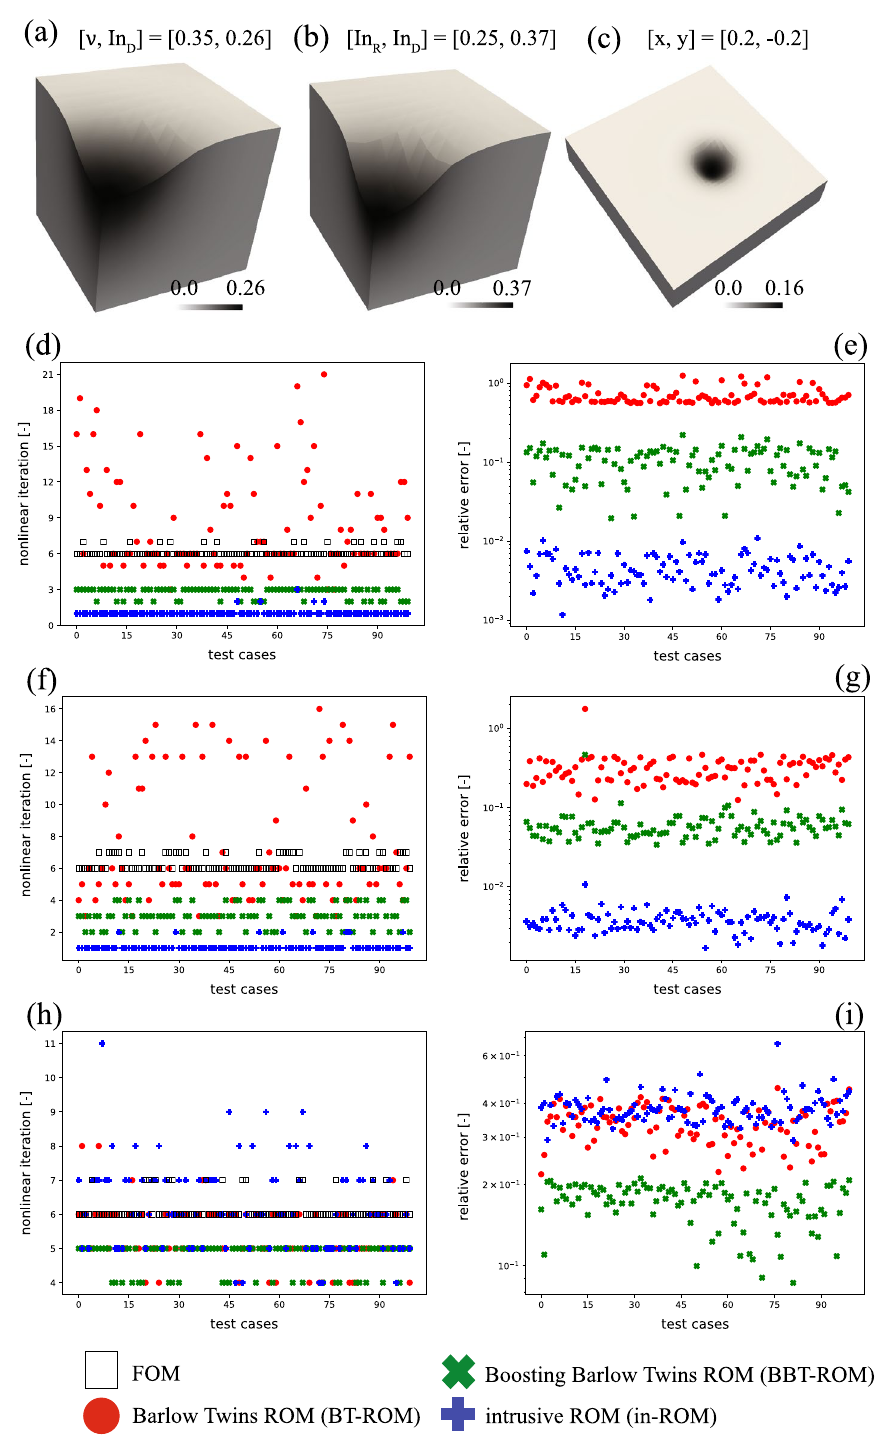
Figure 3. Example 2 - results: samples of test dataset results where ( a ) ν and In D are parameters, ( b ) In R and In D are parameters, and ( c ) indentation location ( (cid:31) x , y (cid:30) ) is a parameter. ( d ) Number of nonlinear iterations and ( e ) relative error of test dataset results where ν and In D are parameters, ( f ) number of nonlinear iterations and ( g ) relative error of test dataset results where In R and In D are parameters, and ( h ) number of nonlinear iterations and ( i ) relative error of test dataset results where indentation location ( (cid:31) x , y (cid:30) ) is a parameter. The nonlinear solver iteration using default FOM initialization, zero-vector initialization, is shown with a black square, BT-ROM-assisted is shown with a red dot, BBT-ROM-assisted is illustrated with a green cross, and in-ROM- assisted is presented with a blue plus. The relative error (see Eq. 3) is calculated between each ROM (BT-ROM (red dot), BBT-ROM (green cross), or in-ROM (blue plus) and FOM (black